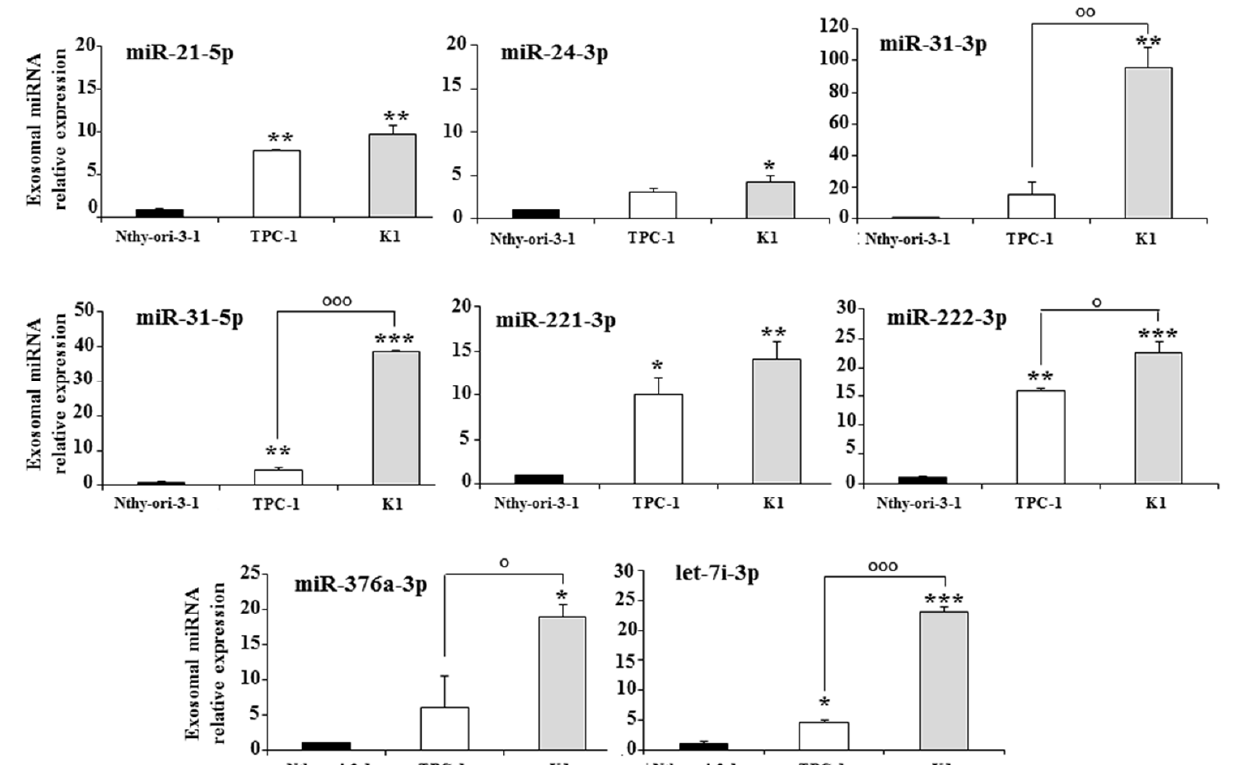
Figure 2. Exosomal miRNAs differentially expressed in the media of a non-tumorigenic thyroid cell line (Nthy-ori-3-1) and of two PTC cell lines (TPC-1 and K1); miRNA expression levels are reported as the mean expression value of each PTC cell line and normalized to the mean expression of the Nthy-ori-3-1 cell line (equal to 1). Error bars represent standard deviation; p -values were obtained by using one-way ANOVA with Tukey’s multiple comparison test: * p < 0.05, ** p < 0.01, *** p < 0.001 vs. Nthy-ori-3-1; ° p < 0.05, °° p < 0.01, °°° p < 0.001 vs. TPC-1.